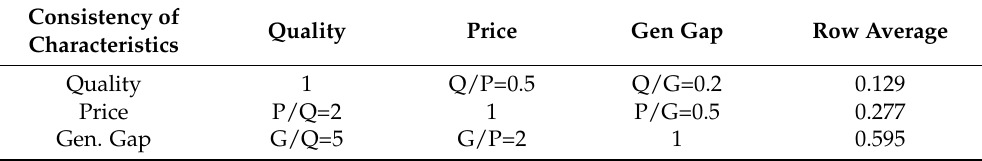
Table 4. Pair-comparison weight rate of quality, price, and generation gap.